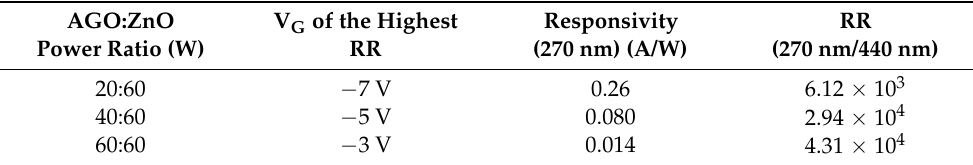
Figure 5. ( a ) Transfer characteristics of TFT (power of AGO:ZnO = 60:60) under illumination; ( b ) Output characteristics of TFT (power of AGO:ZnO = 60:60) under illumination and in the dark. Red curves are the results measured under illumination and the blue curves are in the dark. The symbols represent the operated gate voltage. Table 3. AGZO PTFT measured in the dark and under